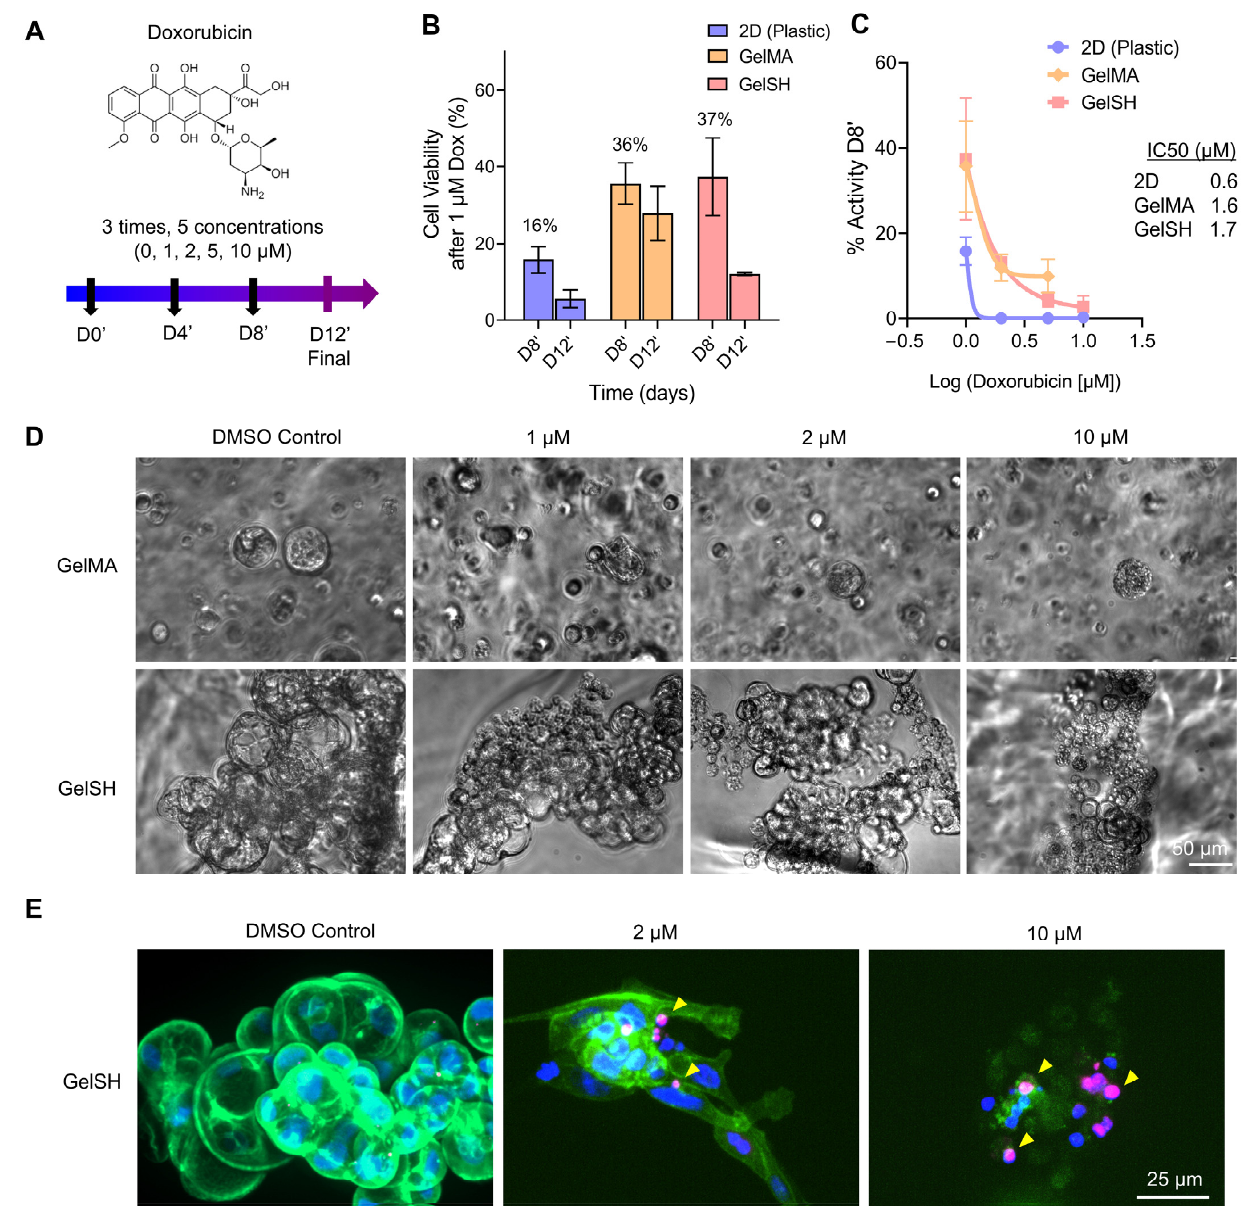
Figure 6. Doxorubicin response in 2D and for 3D PDO culture in gelatin-based biomaterials (GelSH and GelMA) of similar stiffness (3 kPa) from patient-derived cells (P#03F). ( A ) Doxorubicin treat- ment schedule. ( B ) Cell viability in 2D, GelSH and GelMA, following 1 µM doxorubicin treatment (Means ± SE, n = 3–4 technical replicates). ( C ) IC 50 dose responses (Means ± SE, n = 3–4 technical replicates). ( D ) Brightfield images of entire 3D PDO morphology in GelSH and GelMA gels after 4 days of treatment. ( E ) Confocal images of immunofluorescence for DAPI (blue), H2A γ (magenta), Phalloidin (green) staining showing local DNA damage (yellow arrows) after 12 days of drug treat- ment.